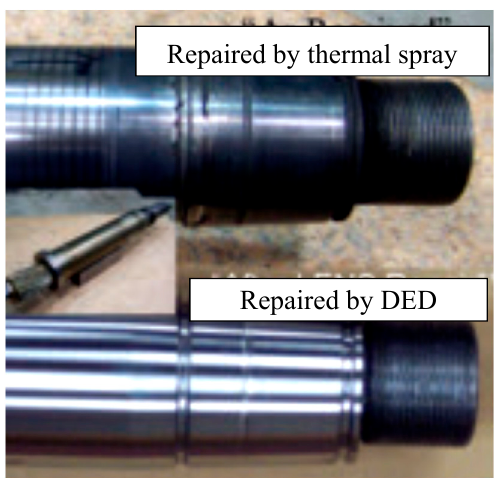
Figure 11. A drive shaft repaired by thermal spray (top) and DED (bottom) processes [87].